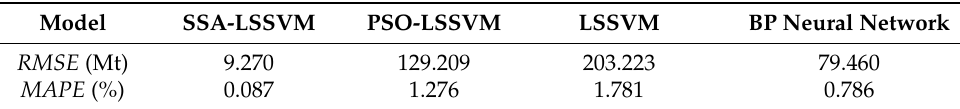
Figure 6. PE values of four forecasting models. Table 3. RMSE and MAPE values of four forecasting